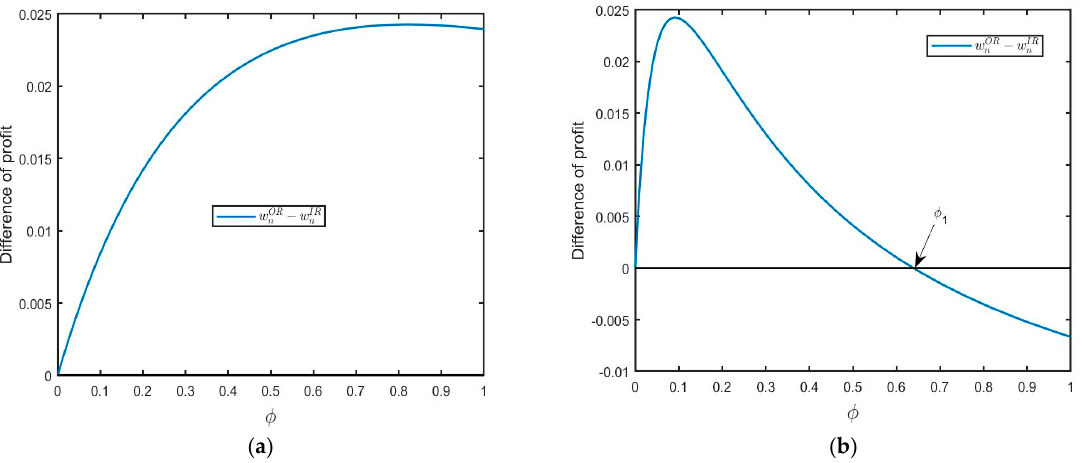
Figure 2. The impact of φ on difference: ( a ) δ < 1 − 3 σ 2 / µ 2 ( µ = 0.9, σ = 0.2, δ = 0.5 ) and ( b ) δ < 1 − 3 σ 2 / µ 2 ( µ = 0.9, σ = 0.2, δ = 0.9 )